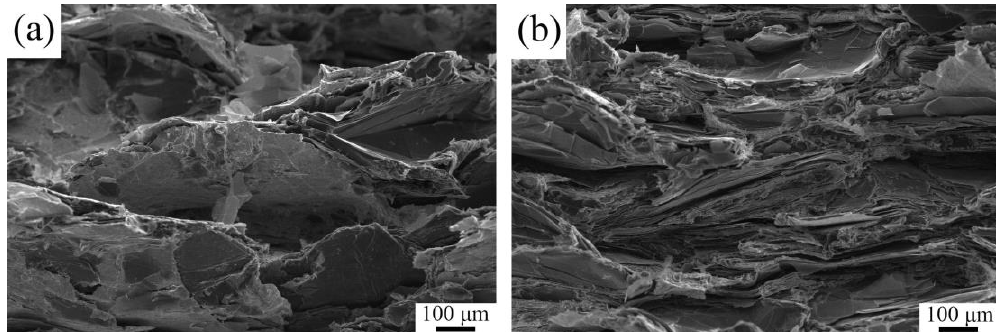
Figure 11. Typical SEM images of fracture morphologies of composites after bending test in X - Y plane of ( a ) uncoated and ( b ) TiC coated graphite flake/Cu composites.